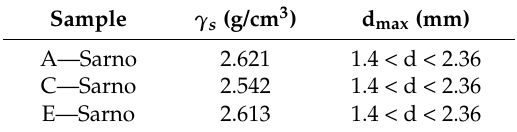
Table 1. Specific weight and maximum diameter class of the tested soils.